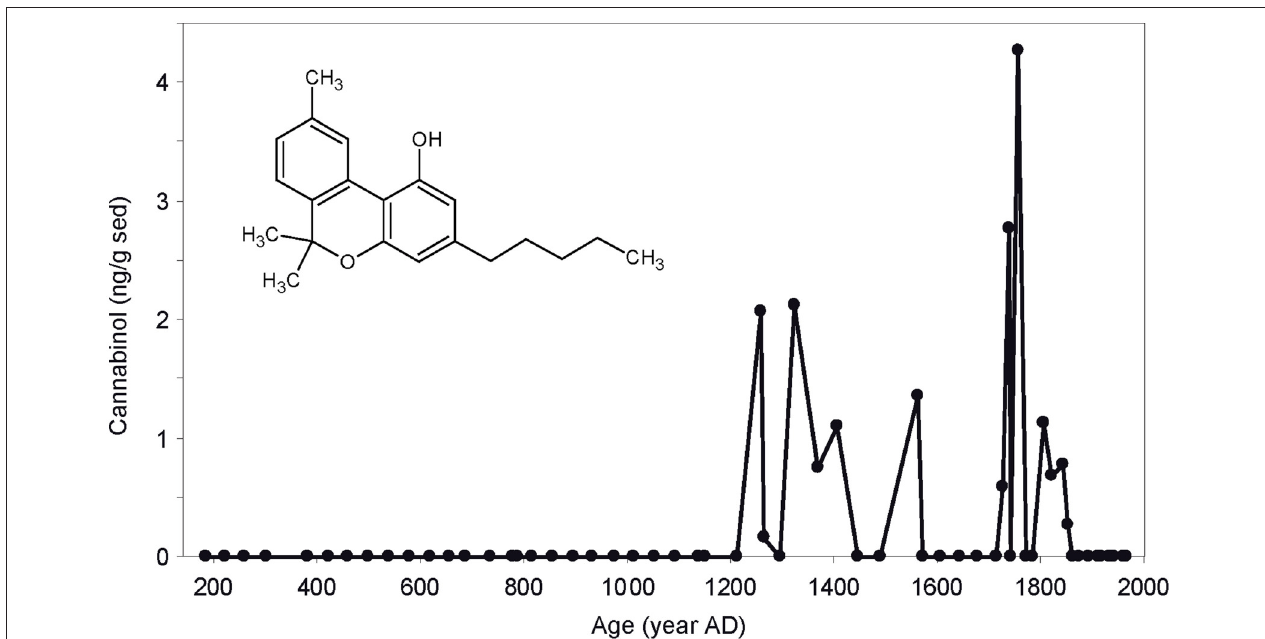
FIGURE 3 | Evolution of cannabinol (structure shown) concentration in the sediments of Lake Aydat since AD 200. Modified from Lavrieux et al.